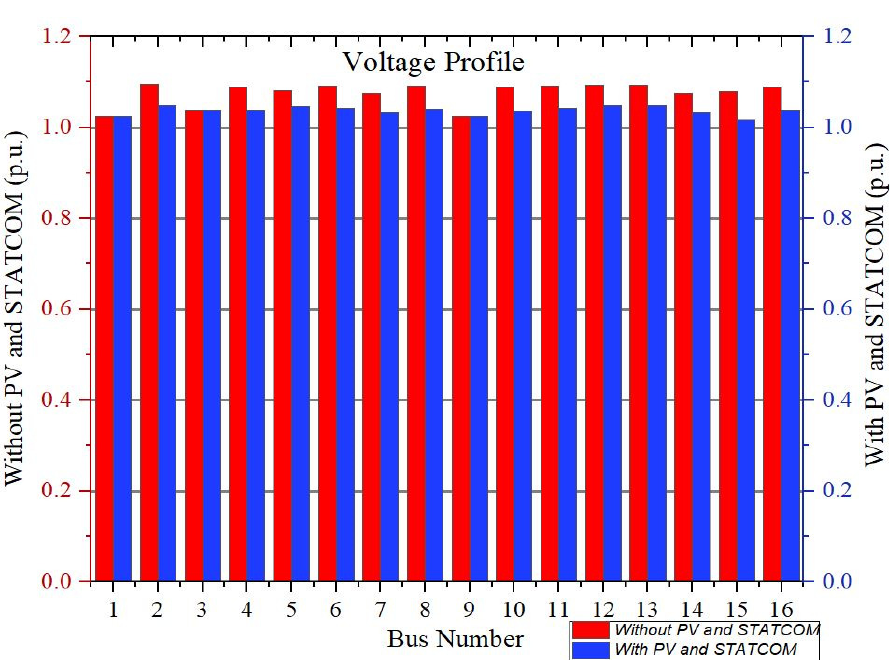
Figure 22. Voltage profile at all buses without and with SPVGP and STATCOM.